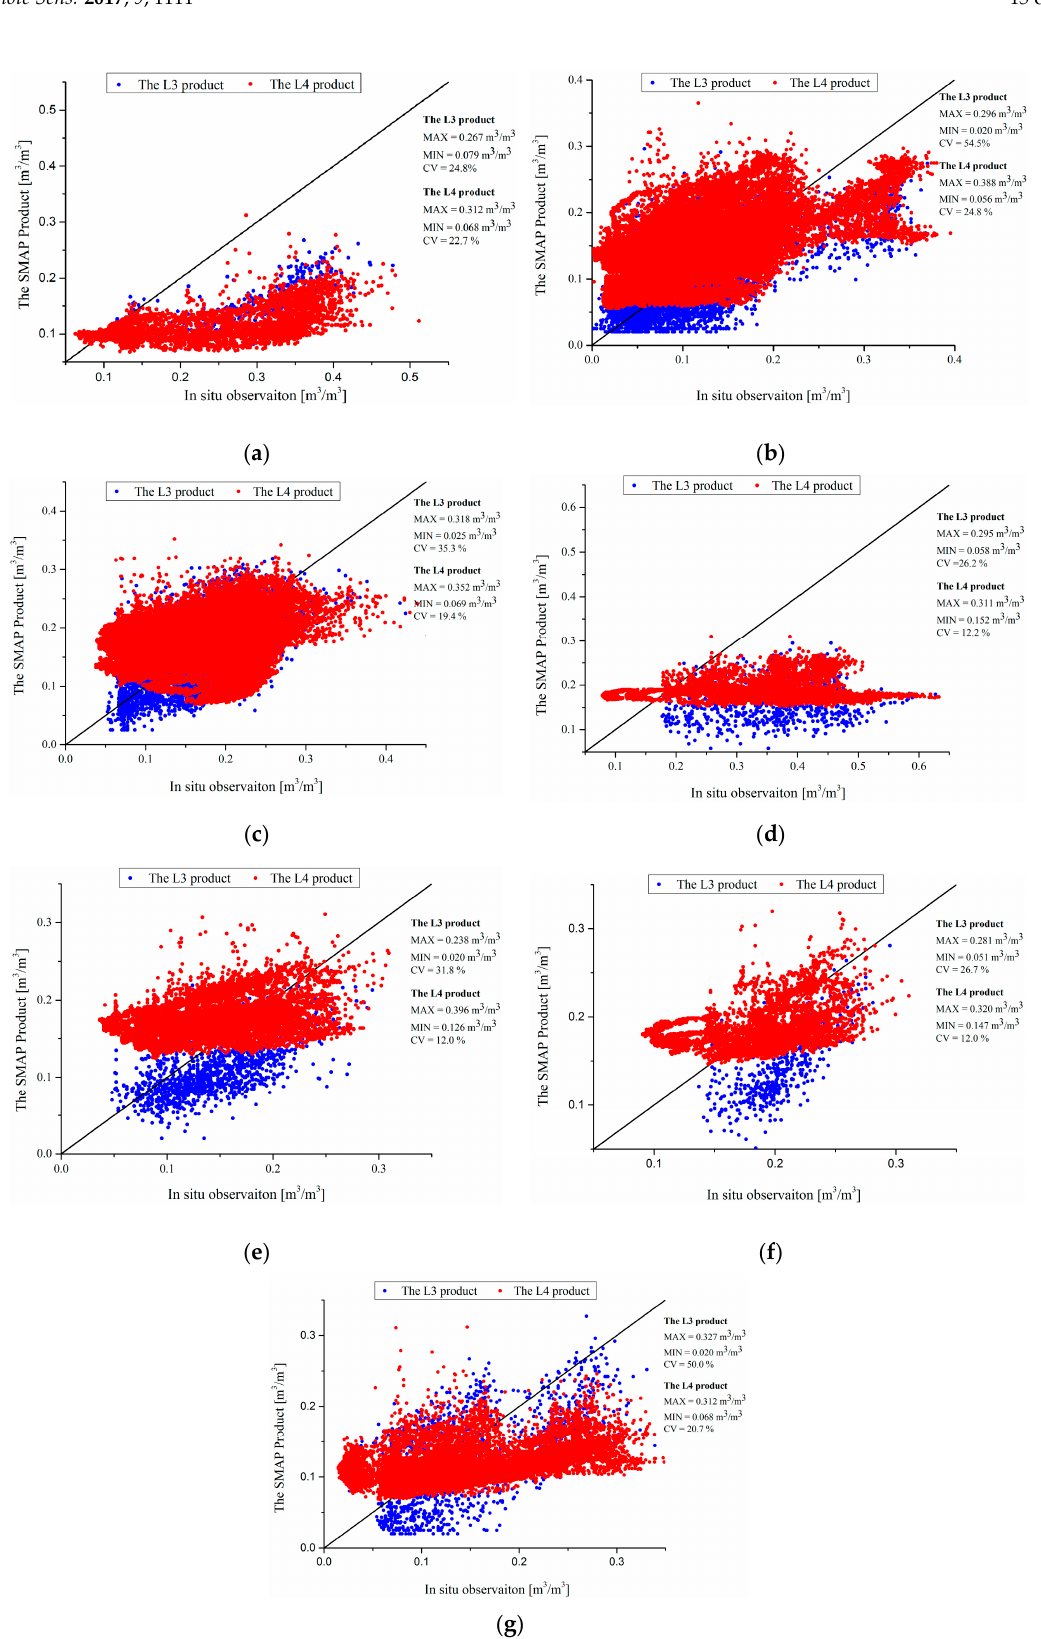
Figure 4. Scatterplots of the SMAP L3 and L4 products and in situ observation in the study area. ( a ) alpine meadow; ( b ) sparse grassland; ( c ) dense grassland; ( d ) shrub; ( e ) coniferous forest; ( f ) cropland; ( g ) barren